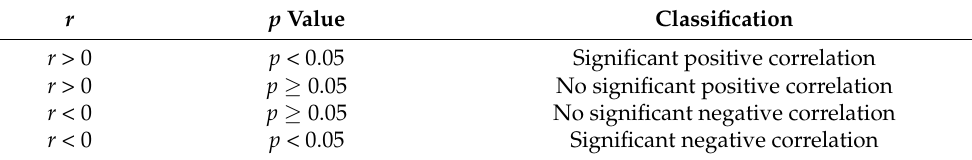
Table 5. Classification of correlations.